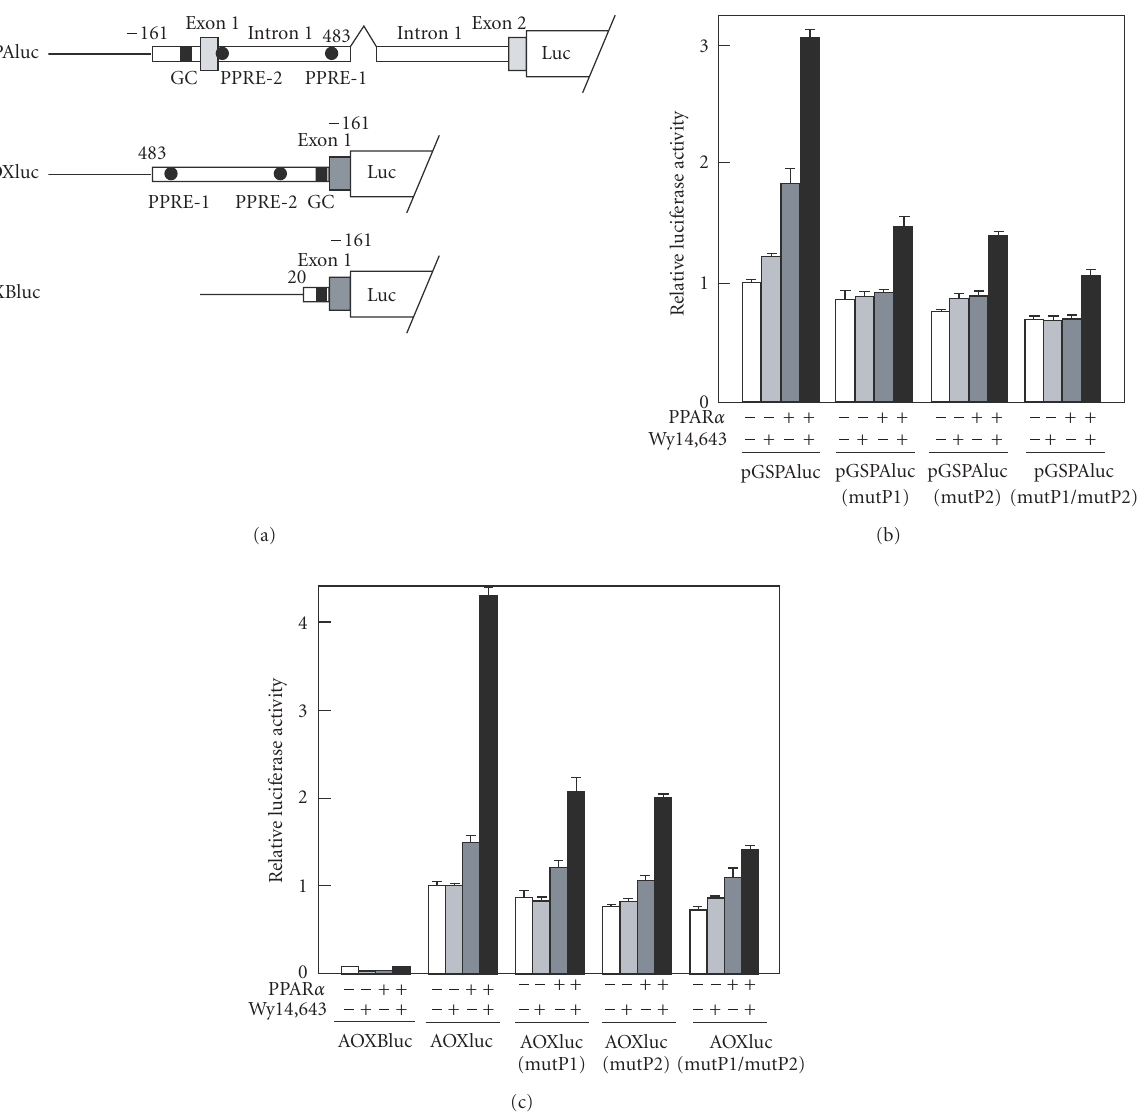
Figure 3: Both PPREs contribute to the PPAR α -dependent transactivation of GSPA and AOX. (a) Schematic view of the reporter constructs. Upstream and intron regions are depicted with horizontally long boxes, whereas exons with vertically long gray boxes. Nucleotide numbers correspond to those in Figure 1(b). The − 161/483 region was included in common in both pGSPAluc and pMmAOXluc in opposite orien- tations. Only parts of 5 (cid:2) noncoding stretches of exon 2 of GSPA and exon 1 of AOX were included in the respective reporters. In pGSPAluc, whole exon 1 that is noncoding and intron 1 were included, while a 5.1 kb region in the middle of intron 1 was omitted. pMmAOXBluc was also prepared as to lack both PPRE-1 and PPRE-2, but retained the GC-rich region. (b) and (c) Reporter assays for GSPA and AOX expres- sions, respectively. pGSPAluc, pMmAOXluc, and their mutants involving PPRE-1 (mutP1), PPRE-2 (mutP2), or both (mutP1/mutP2) were transfected into HeLa cells with or without a PPAR α expression plasmid, and after transfection, the cells were cultured in the presence or absence of Wy14,643. For AOX, a minimal promoter vector, pMmAOXBluc, was also employed. Letters “pMm” are omitted from the names of plasmids in the figure. In both (b) and (c), the luciferase activities are shown as relative values, taking the values of respective wild-type constructs in the absence of PPAR α expression plasmid and Wy14643, as 1. Mean values of three independent assays are given, together with standard deviations. The actual mean luciferase activity values in the presence of both PPAR α and Wy14,643 were 2 . 15 × 10 6 and 2 . 37 × 10 7 luciferase units for pGSPAluc and pMmAOXluc,